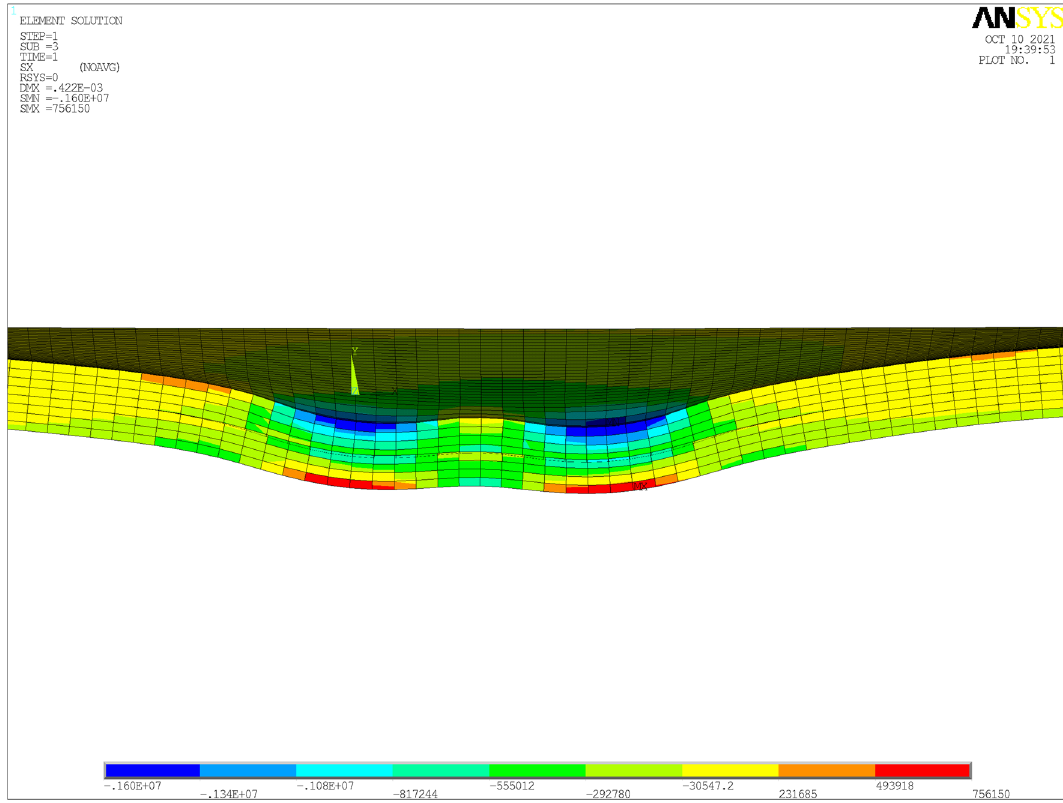
Figure 6. Transverse stress distribution in the deck pavement (Unit: Pa).